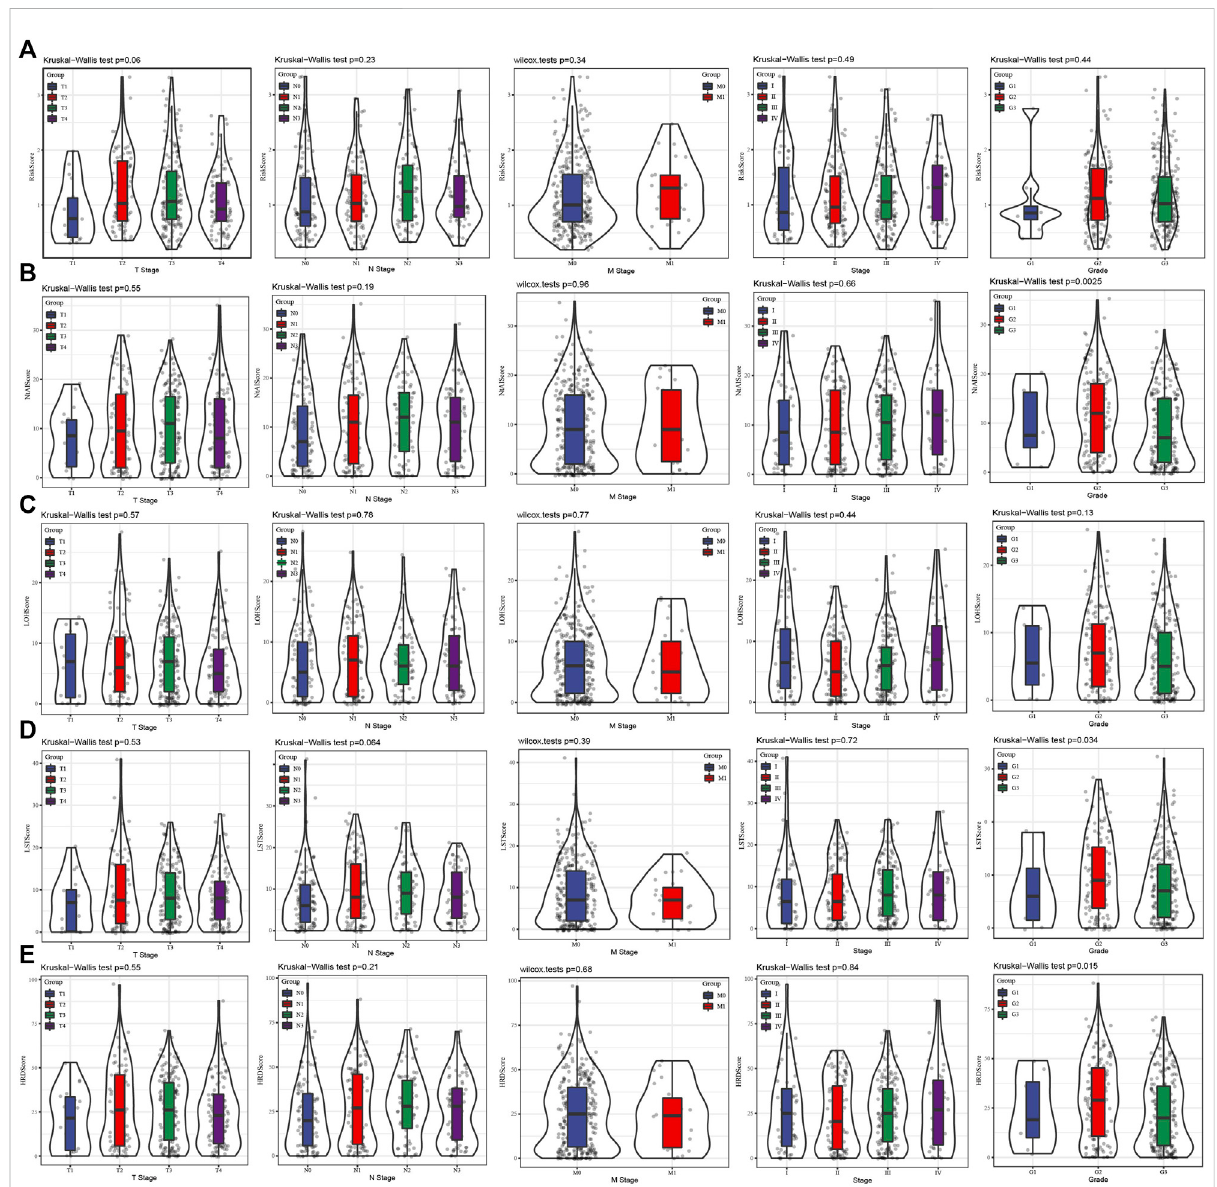
FIGURE 2 Associationbetweenriskscoreanddifferentclinicalstagesandgrade. (A) Theriskscoreofthecasesstrati fi edbyTstage,Nstage,Mstage,AJCC stage and grade. (B) The NtAI score of individuals strati fi ed by T stage, N stage, M stage, AJCC stage and grade, respectively. (C) The correlation betweenLOHscoreandTstage,Nstage,Mstage,AJCCstageandgrade. (D) LSTscoredistributionindifferentTstage,Nstage,Mstage,AJCCstage and grade groups. (E) The association of HRD score with different T stage, N stage, M stage, AJCC stage and